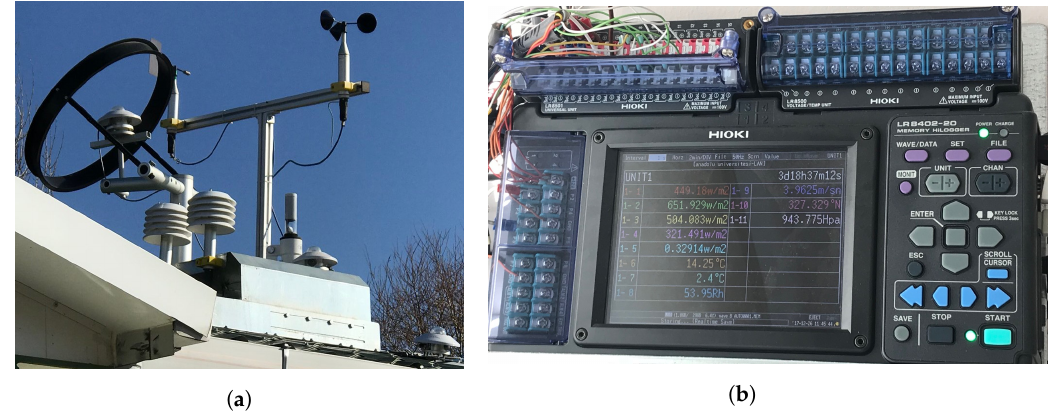
Figure 3. ( a ) Sensors of the weather measurement station; ( b ) Screen view of multichannel real time data logging